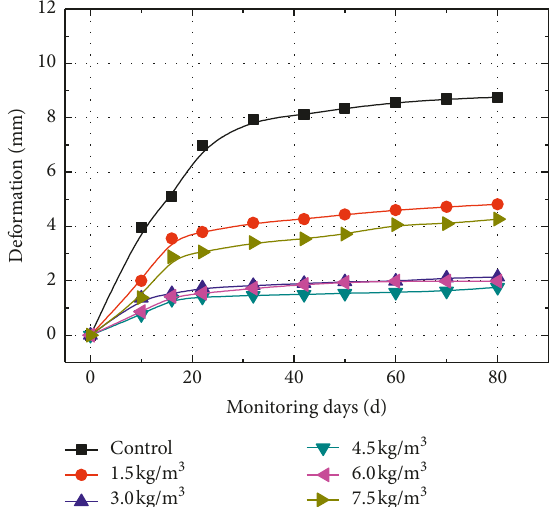
Figure 15: Convergent deformation curve of the